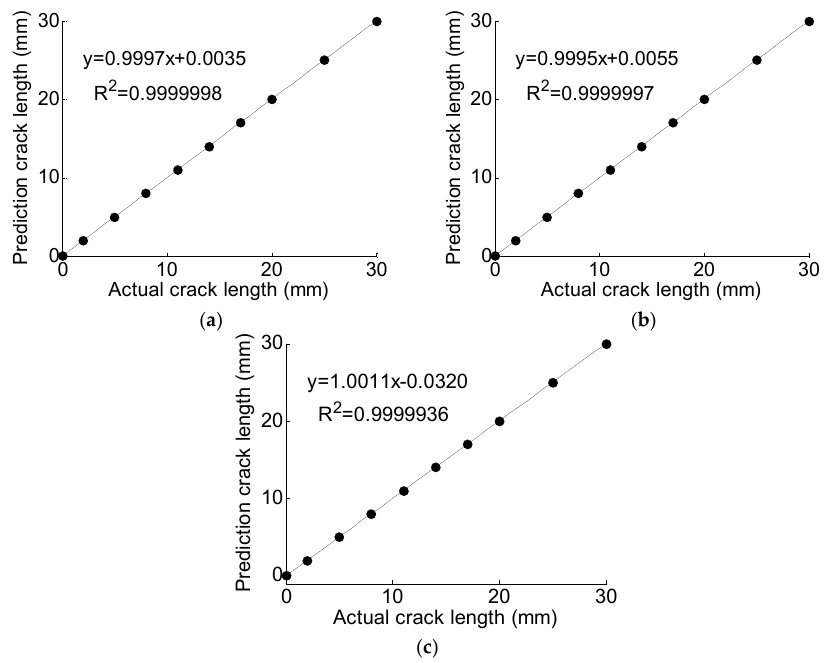
Figure 14. The prediction results using GA based LS-SVM. ( a ) T1; ( b ) T2; ( c ) T3.